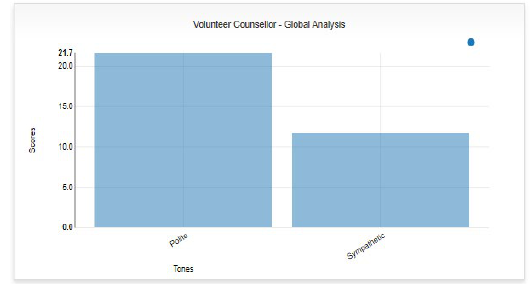
Figure 21 . Average – Tone Analysis (Global)